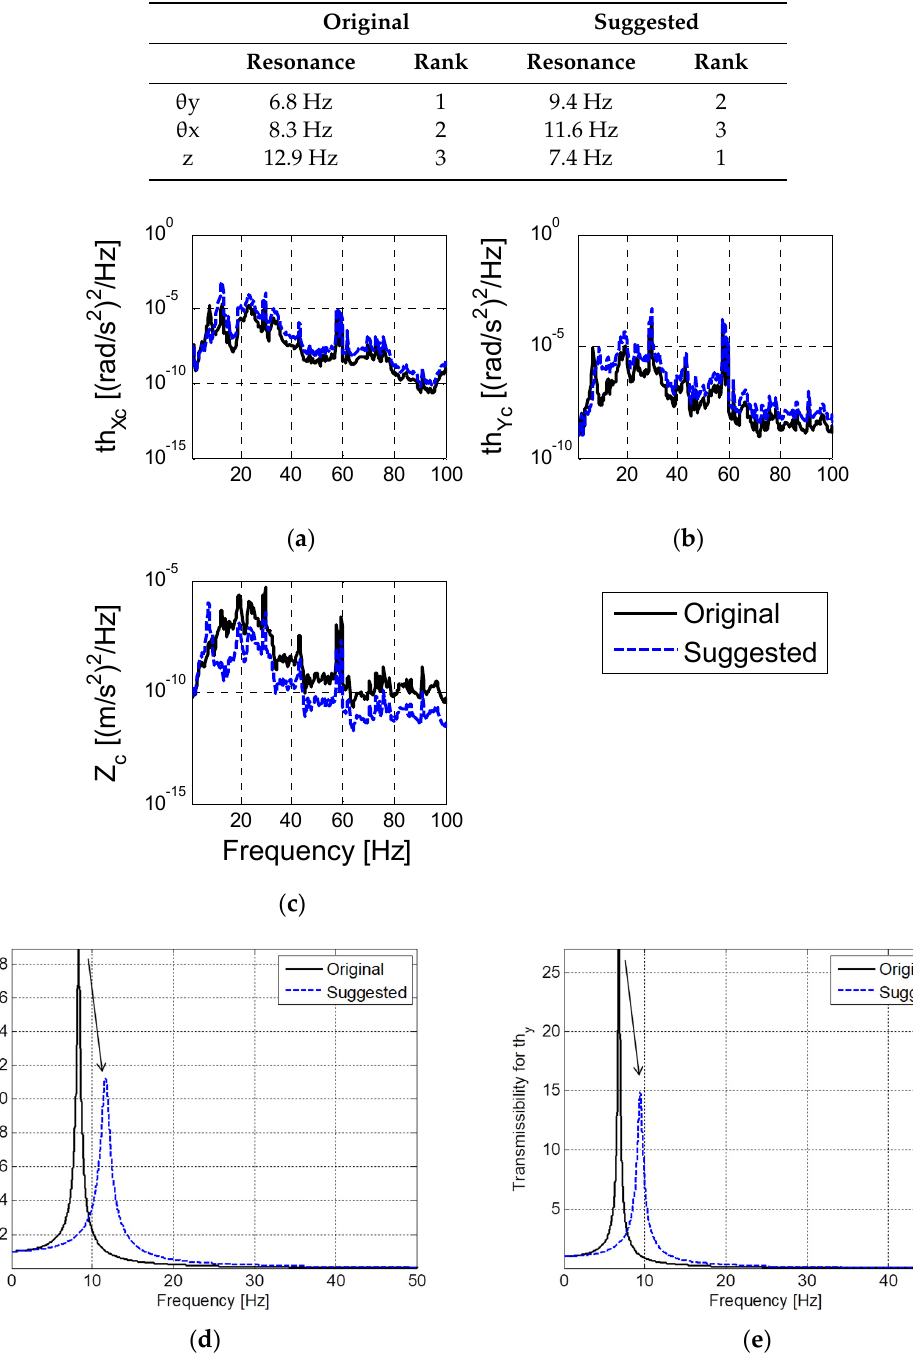
Figure 14. Suggestion for improved mount configuration design. Table 3. Comparison of resonance frequencies between the original and suggested models.